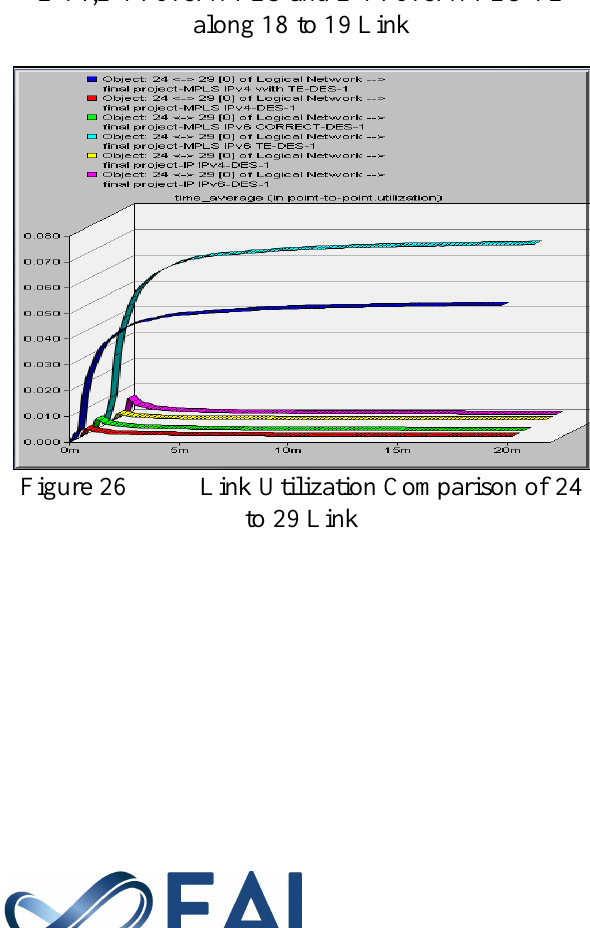
Figure 25 Link Utilization Comparison of IPv4,IPv4 over MPLS and IPv4 over MPLS-TE along 18 to 19 Link